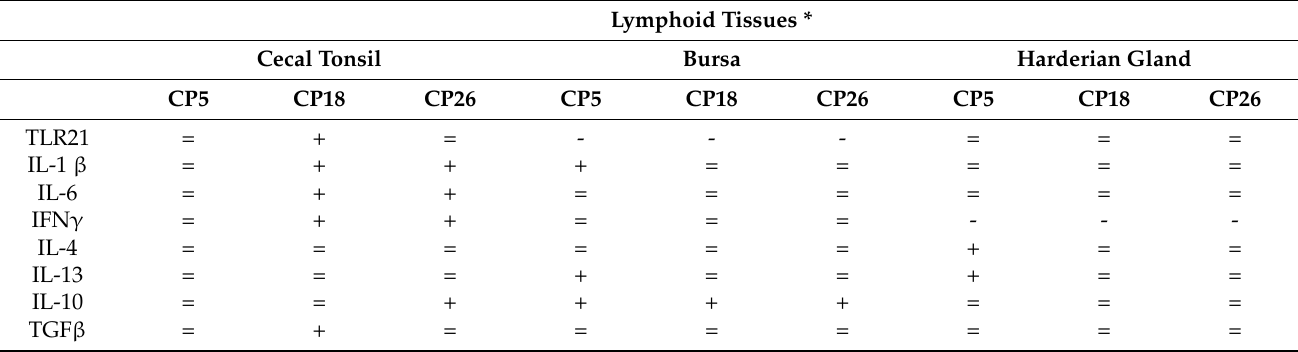
* Data for the spleen are not shown here since no significant changes in the immune gene expression were observed between the infected and control groups. A ‘+’ sign denotes increased ( p < 0.05) and a ‘ - ‘ for decreased ( p < 0.05) gene expression level compared to uninfected control, while a ‘=’ denotes no significant changes compared to uninfected control.